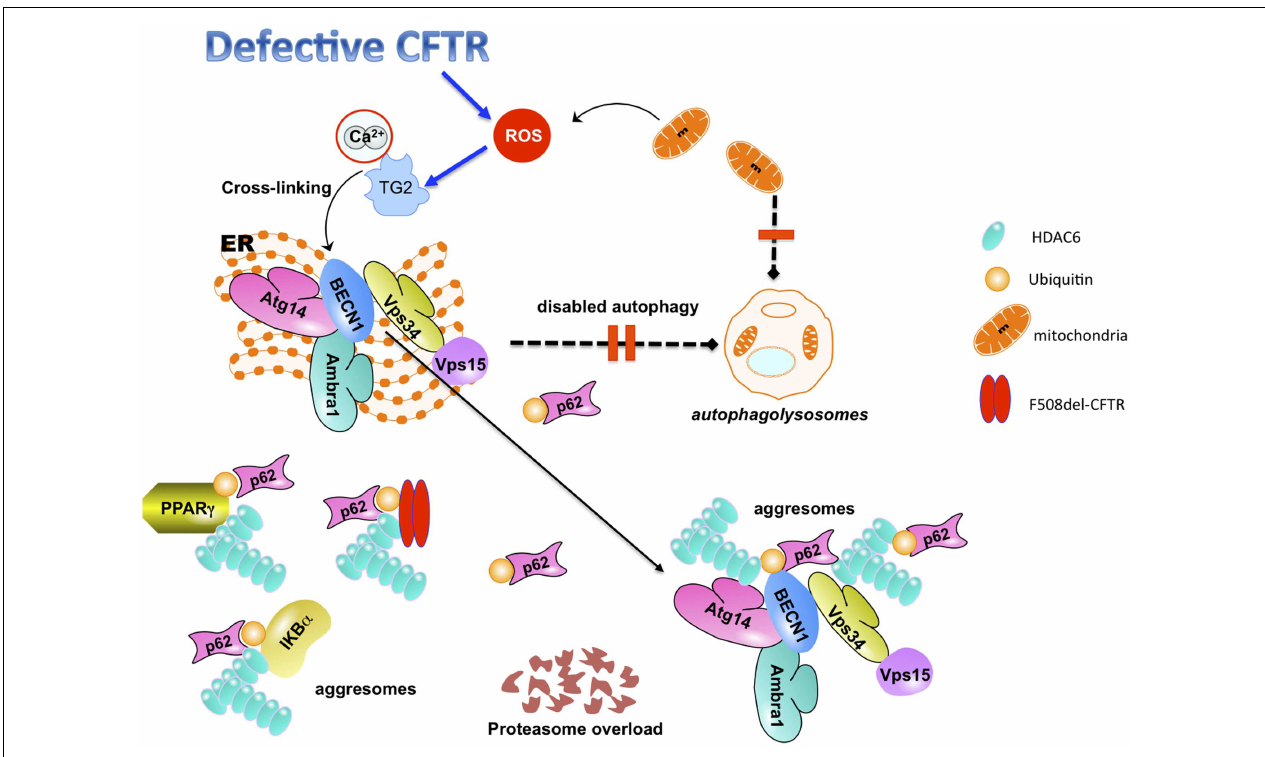
sequestration of cross-linkedTG2 substrates (PPAR γ , I κ B α , BECN1) within HDAC6 + aggresomes.The combined inhibition of protein and aggresome turnover may also favor the accumulation of F508del-CFTR (together with SQSTM1) within HDAC6 + /ubiquitin + intracellular aggregates. Defective autophagy inhibits the clearance of damaged mitochondria that contribute to the generation of pro-inflammatory ROS.